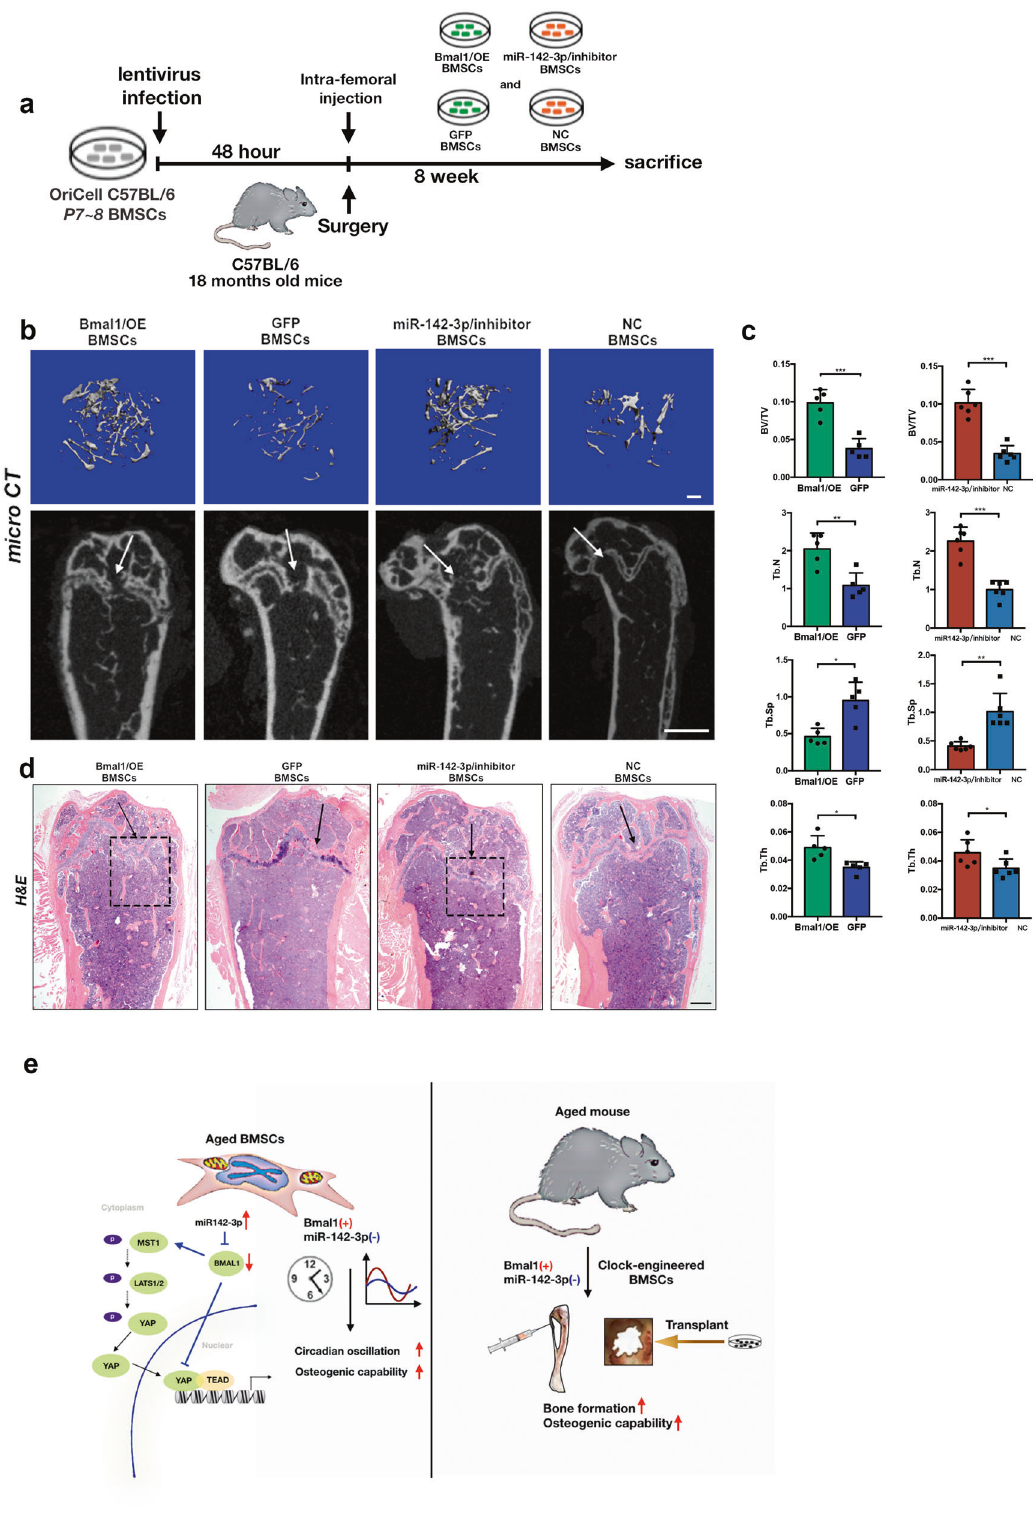
Fig. 7 Supplementation of Bmal1/OE and miR-142-3p/inhibitor BMSCs intra-femur enhance bone deposition in aged mice. a Flow chart diagram of intra-femoral clock-modi fi ed BMSCs delivery. b Representative 3D constructed and sectional images of the metaphyseal region of recipient femurs. Scale bar: 200 μ m for 3D images and 1 mm for sectional images. The arrows indicated the direction of cells delivery. c Quantitative micro-CT analysis (BV/TV, Tb.N, Tb.Th, Tb.Sp) of the injected region of recipient femurs. d H&E staining shows bone volume on recipient femurs. Scale bar: 200 μ m. The arrows and boxes indicated the injection site and assumed regenerating area. e Graphical summary of mechanisms underlying the clock-modi fi ed BMSCs therapy on aged mice via the miR-142-3p/Bmal1/YAP signaling axis. N = 5 – 6, Data are presented as mean ± SD; * p < 0.05, ** p < 0.01, *** p < 0.001 by two-tailed Student ’ s t -tests.